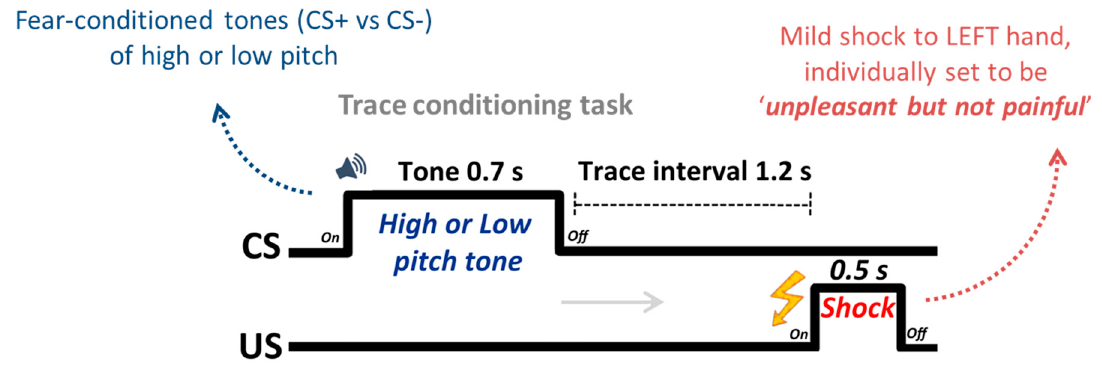
Figure 1. Trial structure for the fear conditioning task. A total of 30 trials were presented in a random order: 10 CS+ with shock, 10 CS+ without shock and 10 CS − tones. Thus, CS+ tones were followed by a shock with a 50% partial reinforcement schedule.